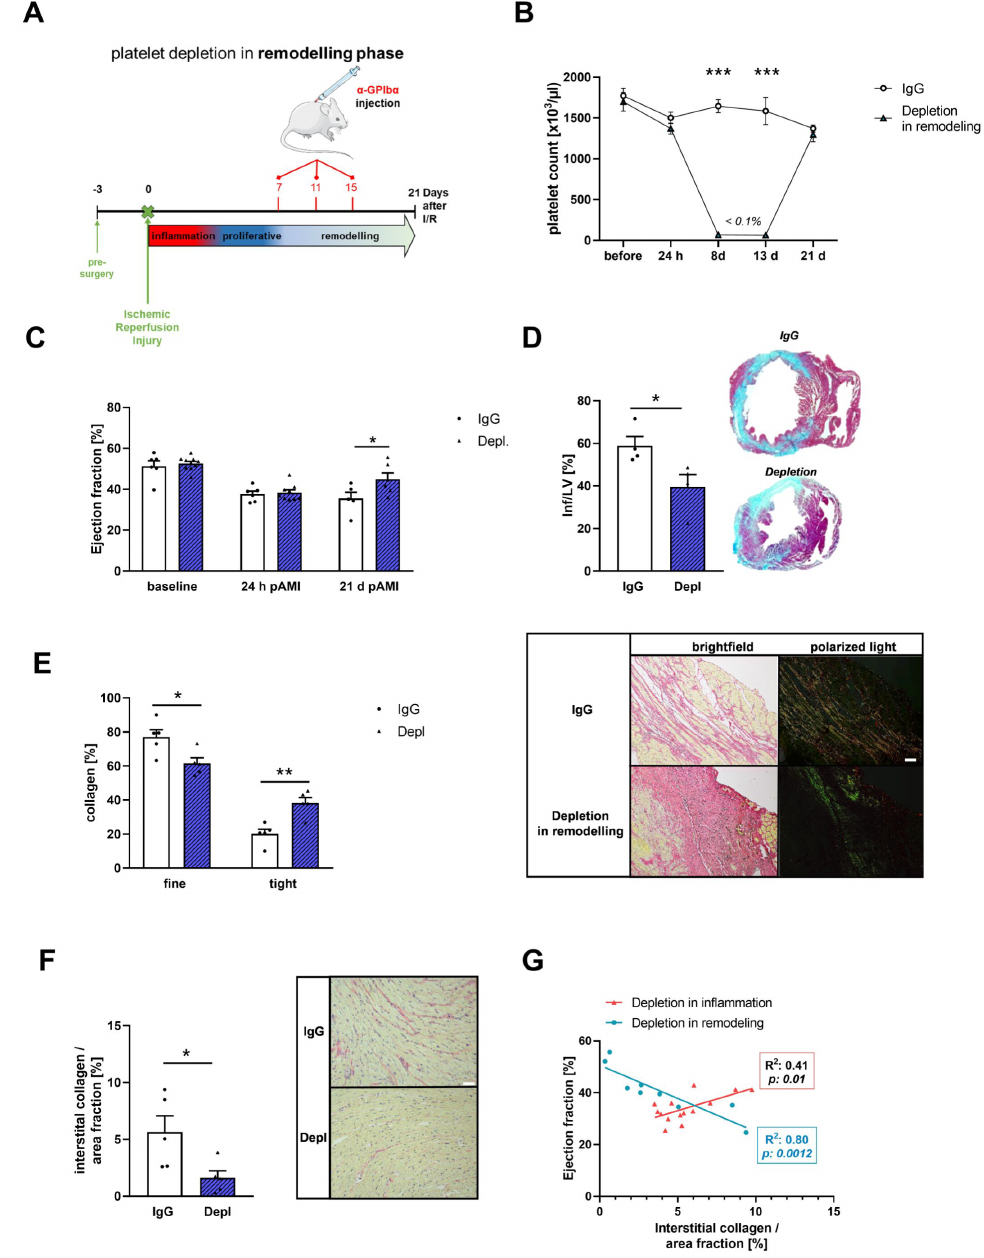
Figure 4. Platelet depletion in the remodeling phase after ischemic/reperfusion injury results in altered scar formation. ( A ) Time schedule of platelet depletion and induction of I/R in mice. Platelets were depleted in the remodeling phase and compared to IgG injected controls. Mice received 4 µ g/g platelet depletion antibody at indicated time points to induce platelet deletion for 96 h per injection. ( B ) Platelet counts at different time points. n = 5–8 ( C ) Echocardiographic analysis of ejection fraction (baseline vs. 24 h vs. 21 days after I/R) of IgG injected and platelet depleted mice; n =